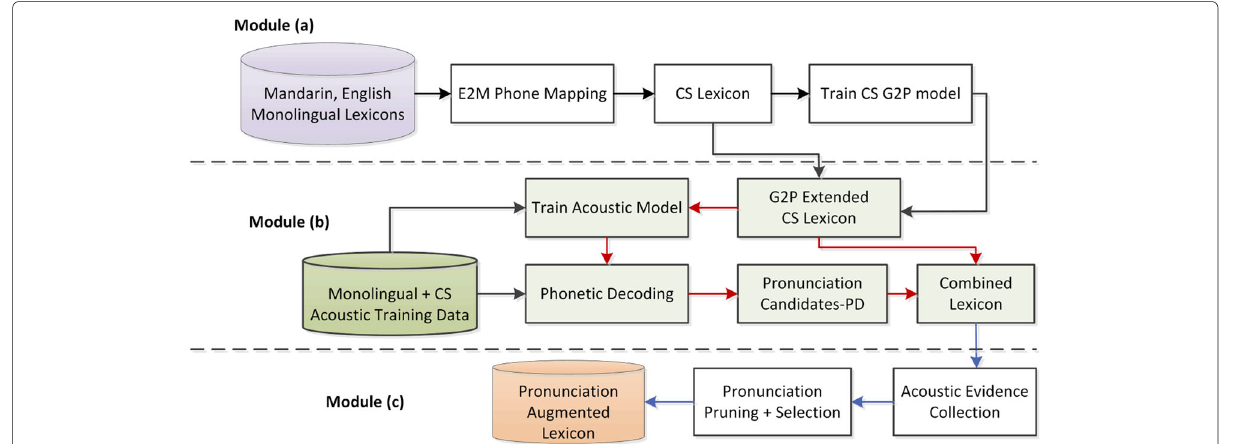
Fig. 3 The proposed pronunciation augmentation framework of embedding language words in CS ASR using lexicon learning